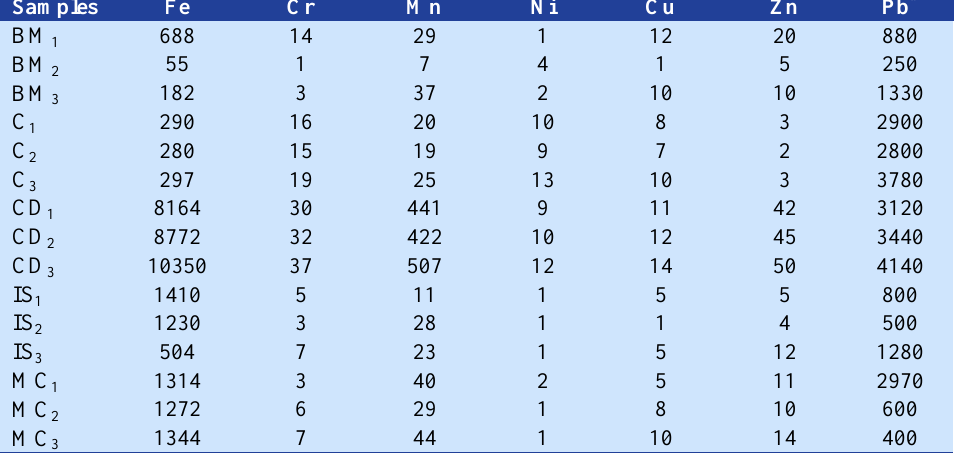
The experiment was performed 3 times and its results are presented in detail: 1; Experiment 1, 2;